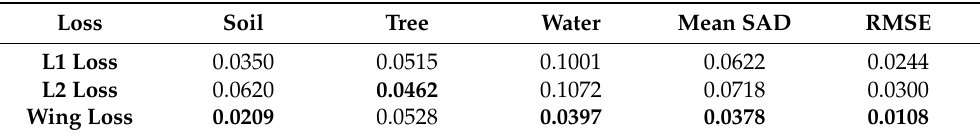
Table 5. Comparison of different loss functions used by the proposed network in Samson Dataset. The best results are shown in bold.